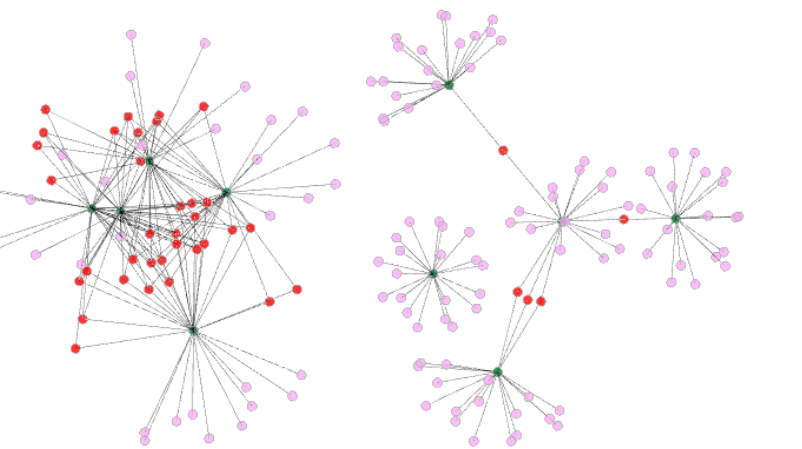
Figure 18. D1 t-SNE representation, Boolean-TF weighting scheme, K = 5, without post-processing ( left ) and with post-processing ( right